Question: Sum up the contents of this chart in one sentence.
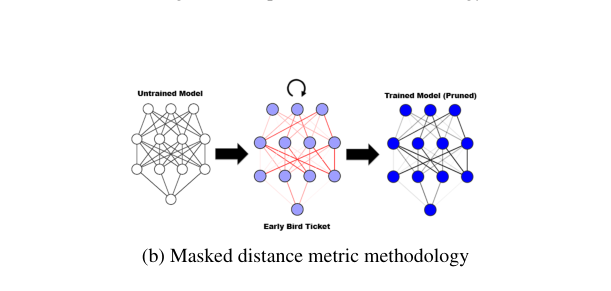
Answer: Comparison of Transformer training methods